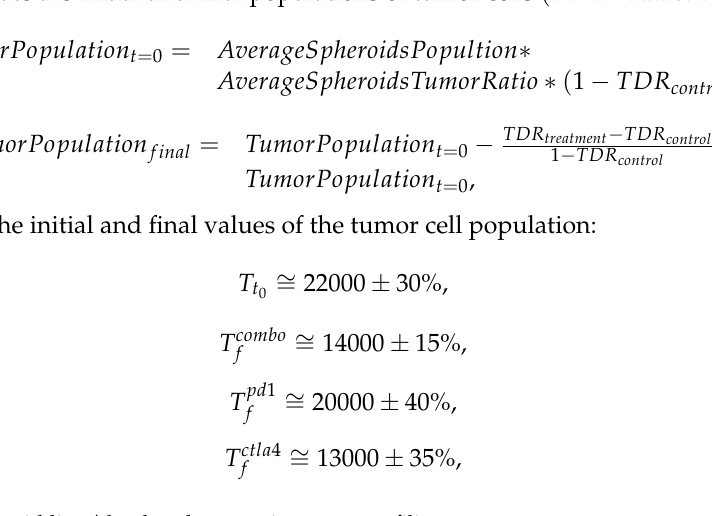
Table A1. Spheroid live/dead and tumor–immune